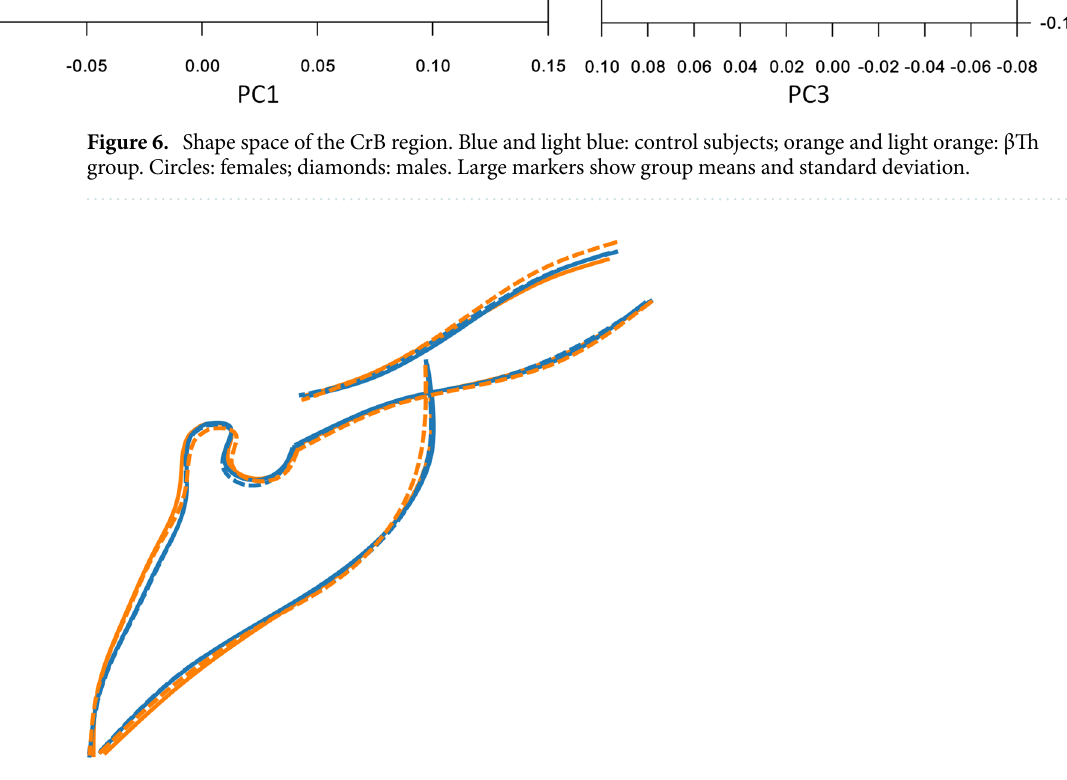
Figure 7. Procrustes superimposition of the average shapes of the cranial base. Orange: βTh group, blue: Ctrl group, solid line: males, dotted line: